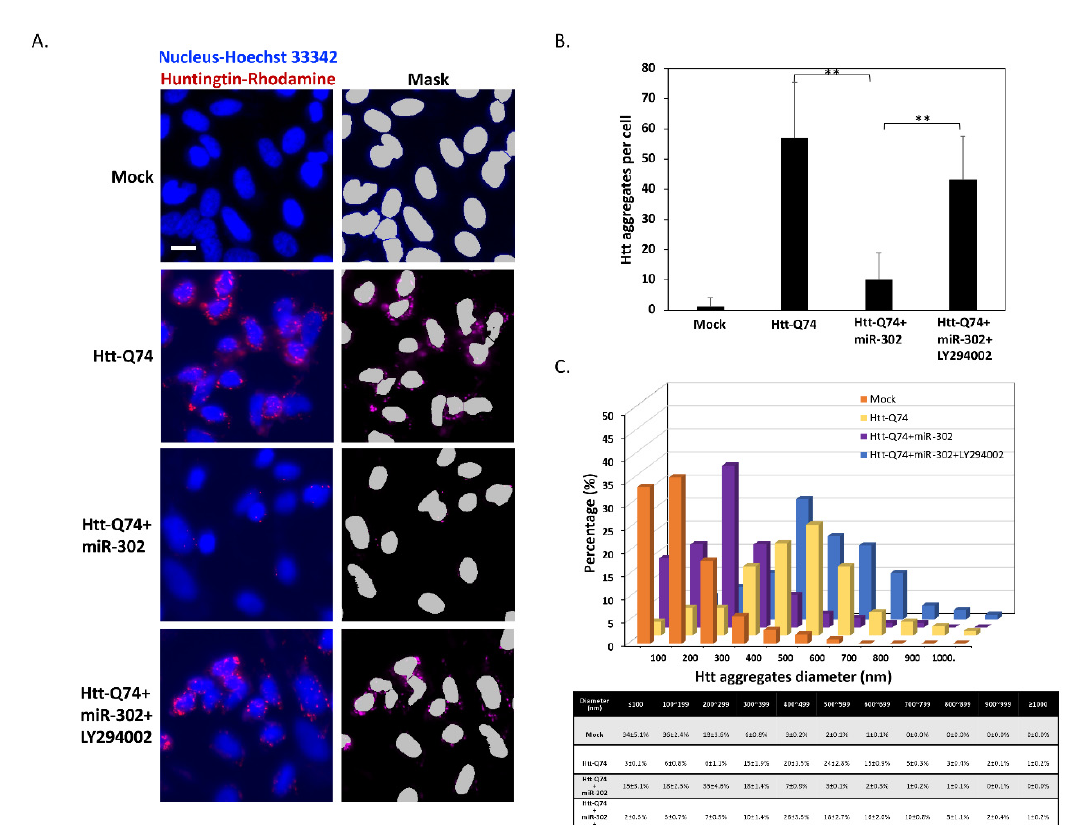
Figure 5. miR-302 cluster reduces the number and size of mHtt aggregates. ( A ) Immunofluorescence staining of Htt shows that 48 h of Htt-Q74 overexpression promotes the formation of Htt aggregates. However, the aggregation is markedly decreased by upregulation of miR-302 cluster. ( B ) The results of the automated high-content analysis indicate that miR-302 significantly reduces average number of mHtt aggregates in mHtt-overexpressing cells. ( C ) the measurements of aggregate demonstrate that mHtt aggregates shifted towards smaller sizes by upregulation of miR-302, whereas co-treated with LY294002 reverses this reduction. All values are presented as mean ± SEM. Significant difference was determined by using the multiple comparisons of Dunnett’s posthoc test for ** p < 0.01. Scale bar represents 5 μ m.